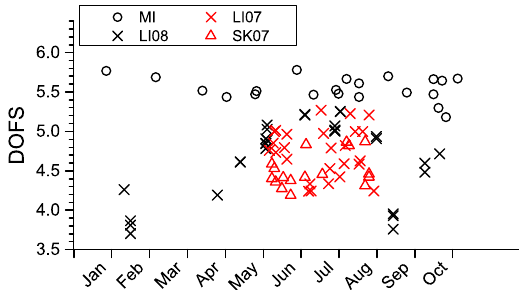
Figure 4. Variation of the DOFS (degrees of freedom for signal) values for the four different